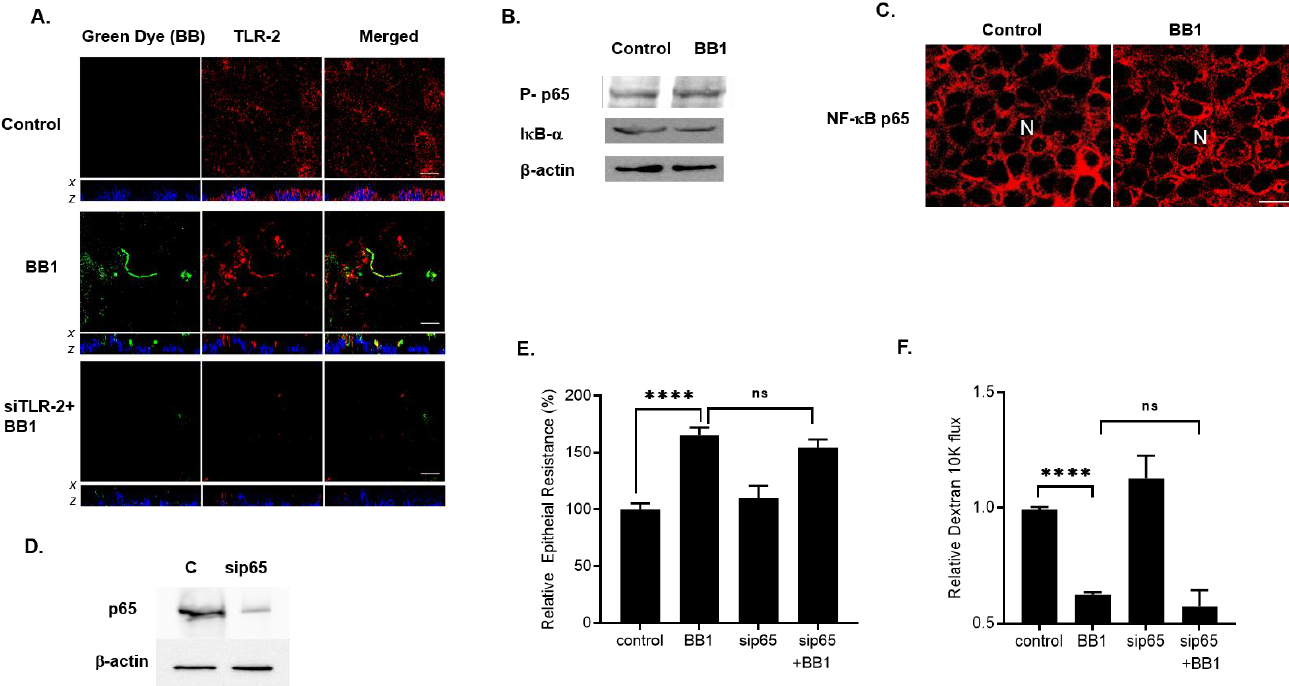
Figure 3. Intracellular mechanisms involved in BB1 enhancement of Caco-2 intestinal epithelial TJ barrier. ( A ) BB1 attachment to the Caco-2 apical membrane surface. In control Caco-2 monolayers, TLR-2 (red) is diffusely distributed on the apical membrane surface. LA1 (green) adheres to Caco-2 apical membrane at sites of TLR-2 (yellow in merge panel, middle row, 2-h treatment). Nuclei are shown in blue color. x–z stacks showed that the BB1 and TLR-2 co-localized on the apical membrane of Caco-2 cells. The siRNA knock-down of TLR-2 (bottom row) showed loss of TLR-2 staining and prevention of BB1 attachment. White bars = 10 µ m. ( B ) BB1 did not affect the activation of NF- κ B p65 as assessed by phosph-p65 expression or the degradation of I κ B- α in Caco-2 monolayers (1-day experimental period). ( C ) BB1 did not affect the cytoplasmic-to-nuclear translocation of NF- κ B p65 as determined by immunofluorescence imaging, 40 × . ( D ) NF- κ B p65 siRNA transfection caused a near-complete depletion of NF- κ B p65 protein expression. ( E ) NF- κ B p65 siRNA transfection did not prevent the BB1-induced increase in Caco-2 TER and ( F ) decrease to dextran 10 kDa flux (1-day experimental period); **** p < 0.001 vs. control; ns: not